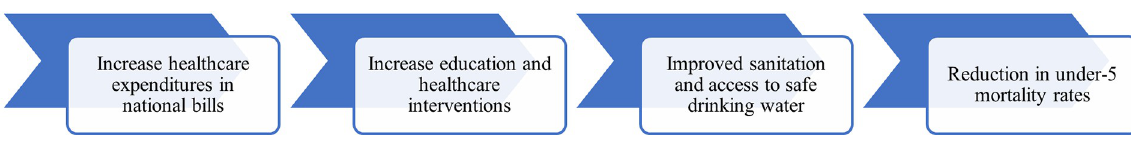
Fig 1. Healthy interventions to reduce under-5 mortality rates. Source: Adapted from Pillai& Christina [28] and authors extract.